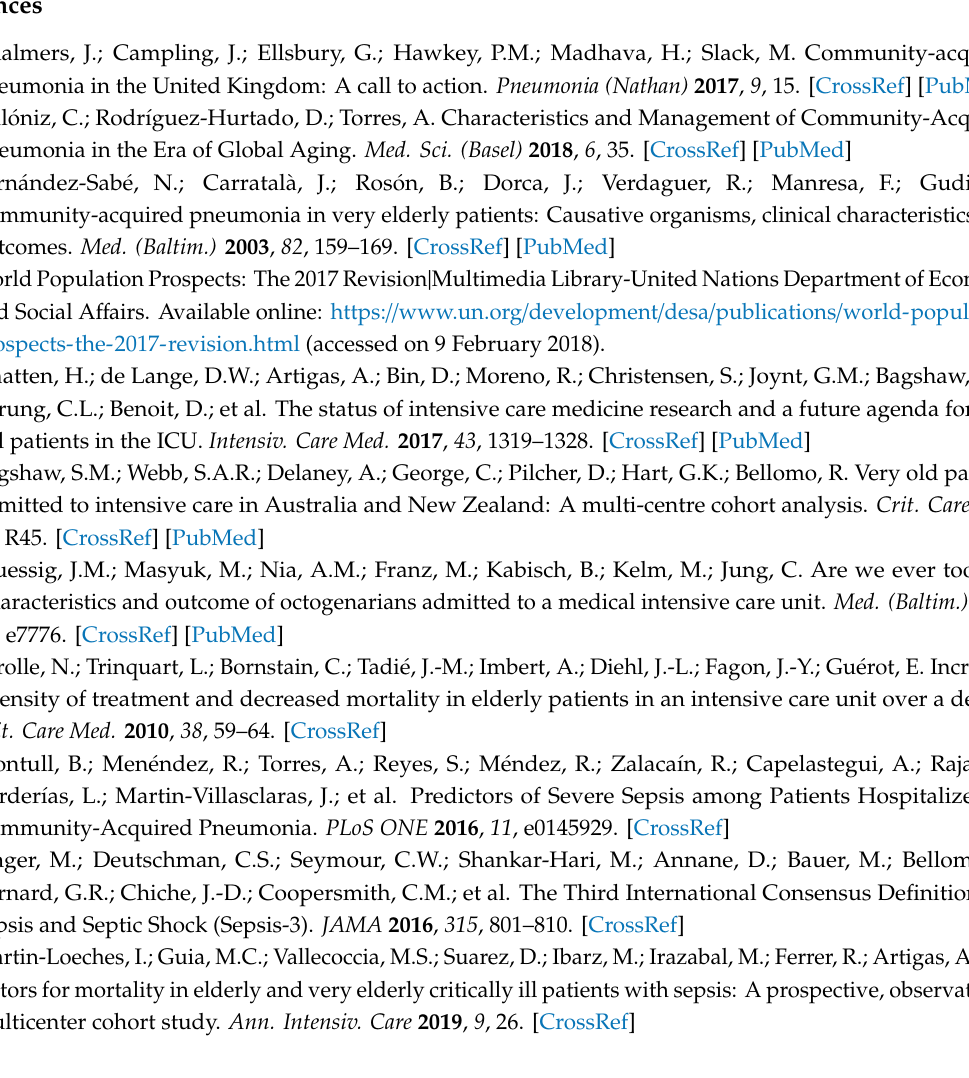
Table S1: Characteristics and clinical outcomes by age group, Table S2: Characteristics and clinical outcomes of very old patients from nursing home and own home environments, Table S3: Characteristics and clinical outcomes of very old ICU and non-ICU patients, Table S4: Characteristics and clinical outcomes of very old patients with and without septic shock, Figure S1: Rate of sepsis by period, Figure S2:Microbial etiology of the study